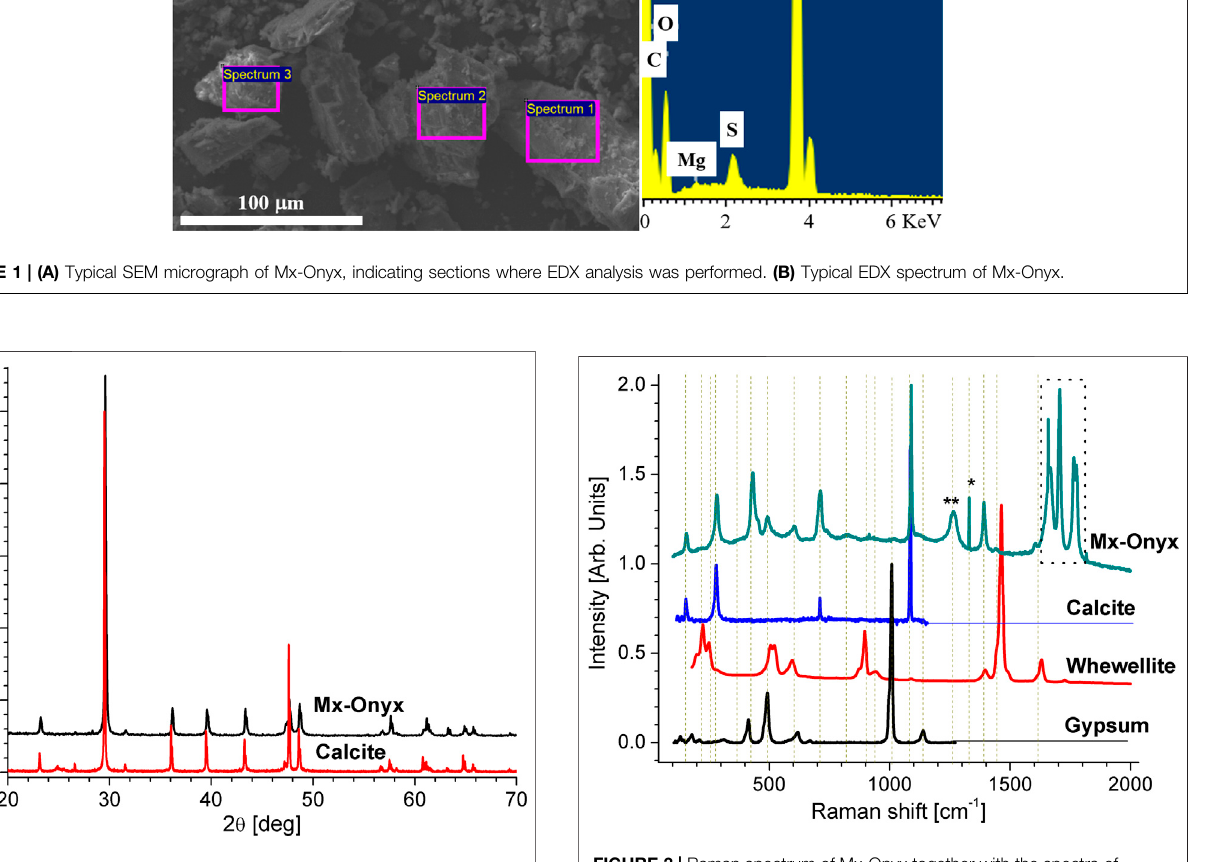
FIGURE2 | XRD pattern of Mx-Onyx. The pattern of calcite (Wang et al., 2018) is presented as reference.